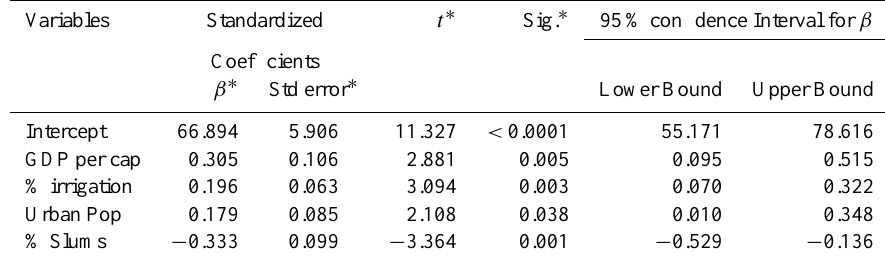
Table 5. Model parameters with water supply as dependent variable – method stepwise (adjusted R 2 =0.686).